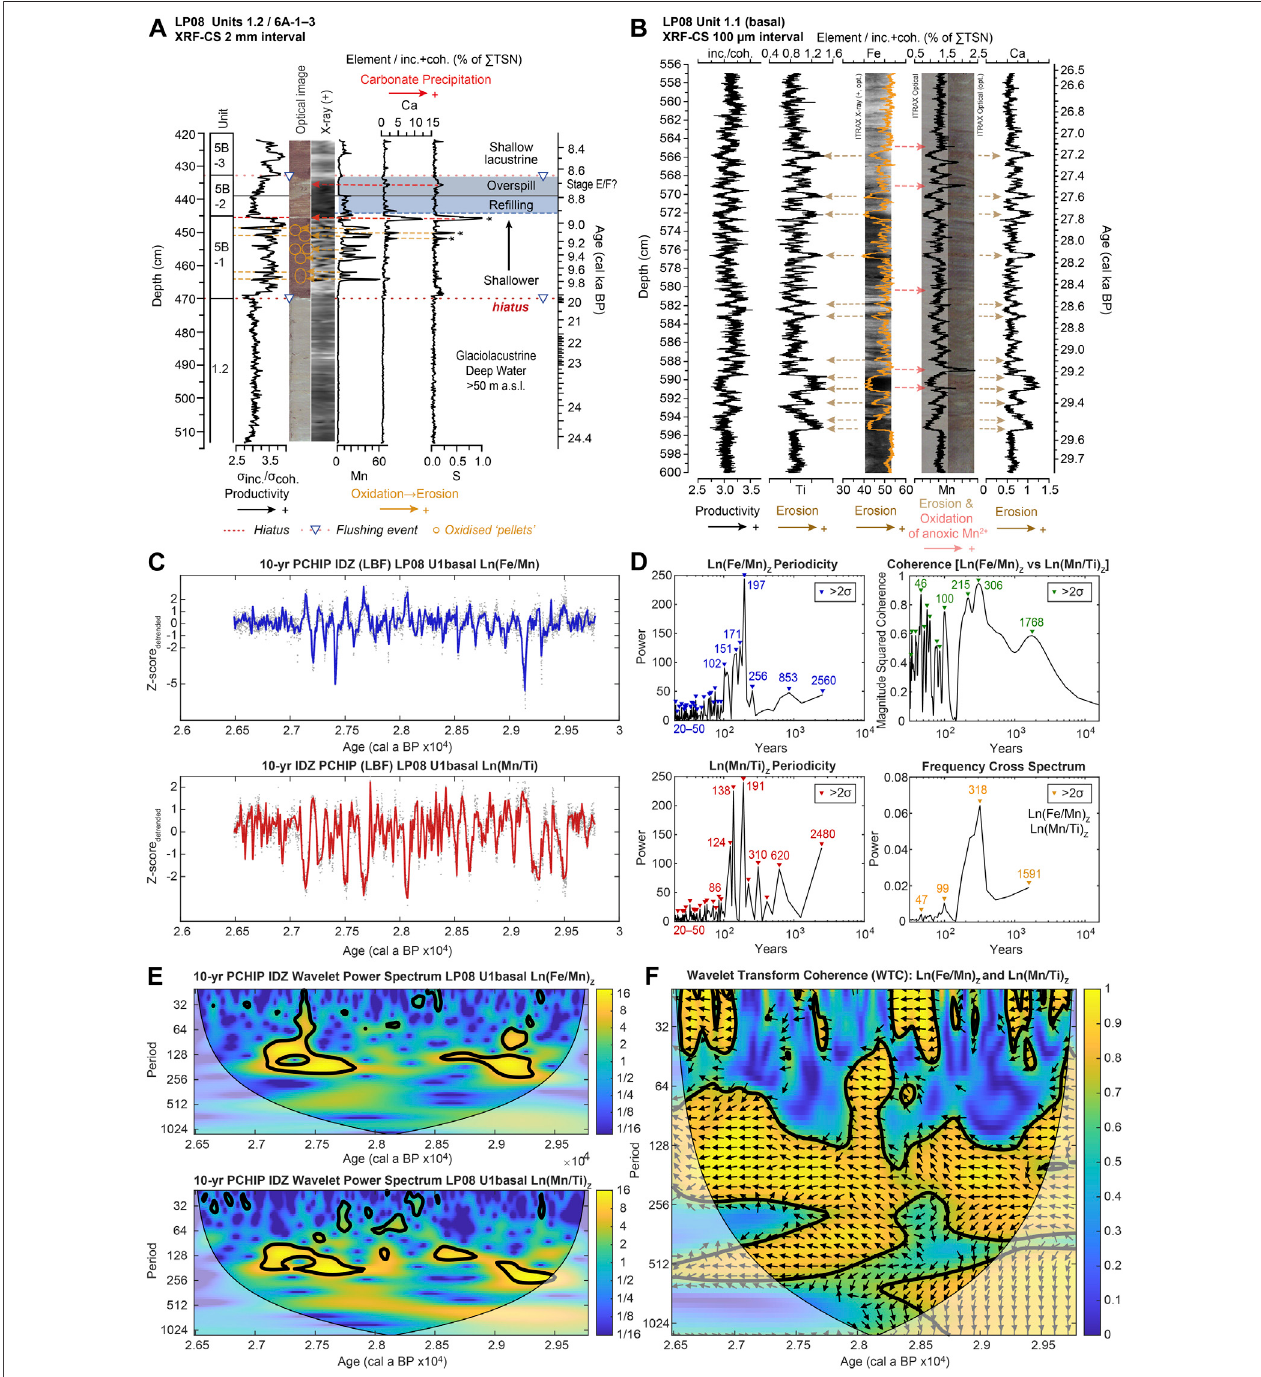
FIGURE 6 | Key geochemical features of the LP08 XRF-CS record. (A) Close-up of the Unit 1/Unit 6 boundary showing the sharp boundary (hiatus) at ~470 cm depth (c. 10 cal ka BP) and Mn-rich nodules, and Ca- and S-rich layers associated with carbonate precipitation in a shallow water (arid) sedimentary environment. A short-lived phase of glacier readvance and reformation of palaeo Lago Tehuelche – Puerto Consuelo to > 40 – < 50 m a.s.l. might have occurred between 8.9 and 8.6 ka (Units 5B-2). (B) Ultra-high-resolution (100 µm; 44 cm core length) XRF-CS data from the LP08 basal core section plotted against depth and weighted mean modelledage(SH20-M1H model). Variationsinorganic(inc./coh.),erosional(Ti/inc.+coh.andCa/inc.+coh.as%TSN),andredox(Mn/inc.+coh.as%TSN)geochemical ratios are shown. (C) Time series analysis of the 10-year PCHIP (Piecewise Cubic Hermite Interpolating Polynomial) interpolated Ln(Fe/Mn) Z-scores (blue line) and Ln(Mn/ Ti) Z-scores (red line) and from the LP08 basal core section (B). The mean sample interval for the dataset (grey dots) is 0.75 ± 0.31 years. (D) Power spectrum periodicity, cross-coherence, and cross-spectrum bi-plots for Ln(Fe/Mn) Z-scores and Ln(Mn/Ti) Z-scores data from (C) with prominent (i.e., > 2-sigma) decadal-to-millennial-scale